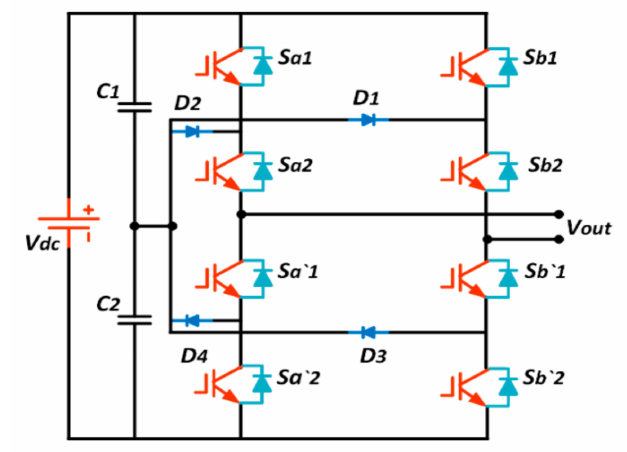
Figure 31. Diode-clamped multilevel inverter